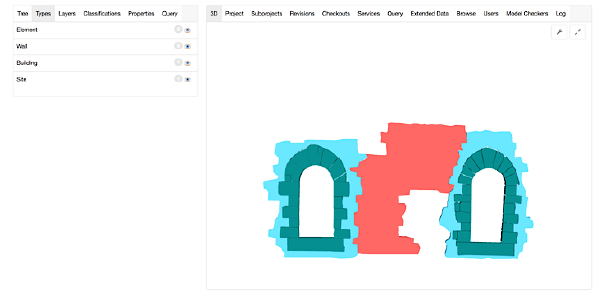
Figure 10. BIM Server. Example of masonry with stratigraphic units. Stone windows (wall cavity) are classified as “element”